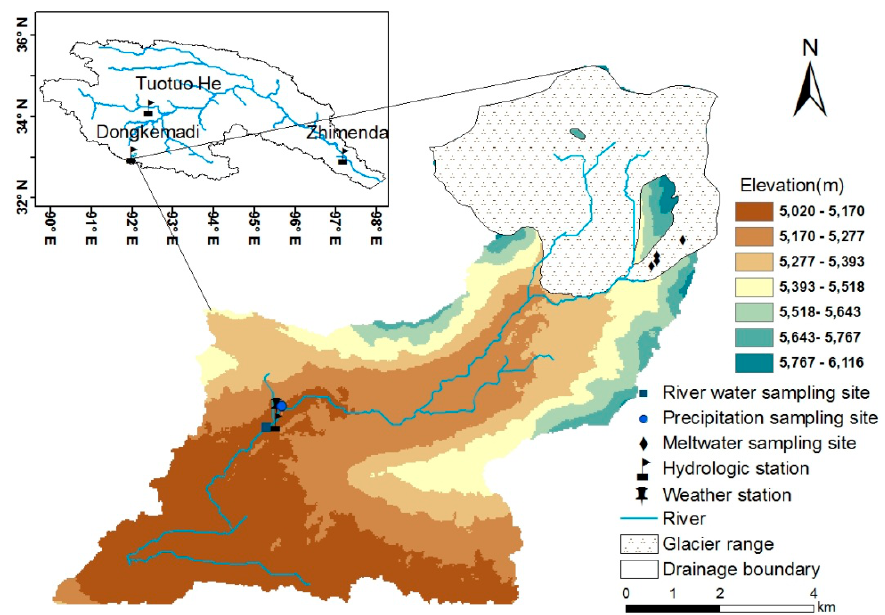
Figure 1. The location of the Dongkemadi River Basin and the distribution of the observation sites.